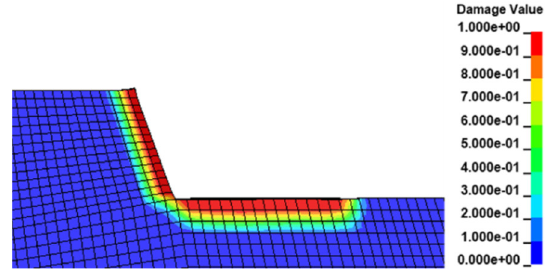
Figure 3. Cloud image showing the slope damage results.